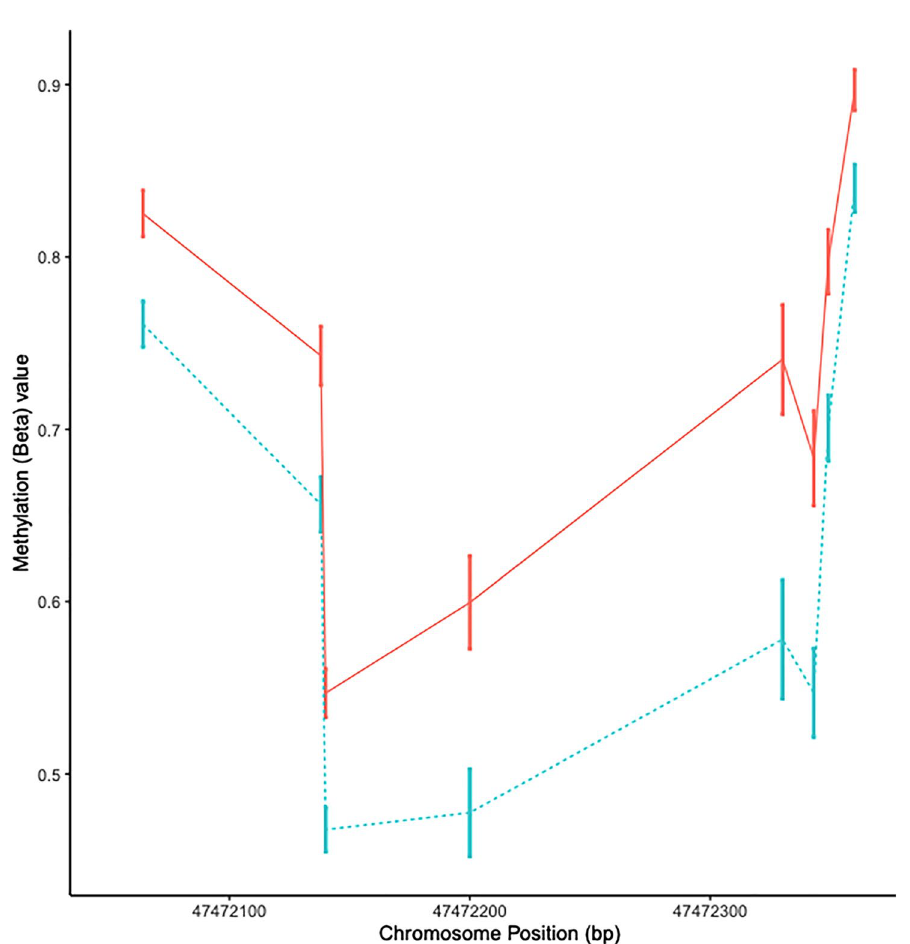
Figure 1. HTR2A DMR plot. The mean beta value at the eight HTR2A CpG sites for controls (solid red line) and SPMS patients (dotted blue line) located within the transcription start site. Error bars show standard error of the